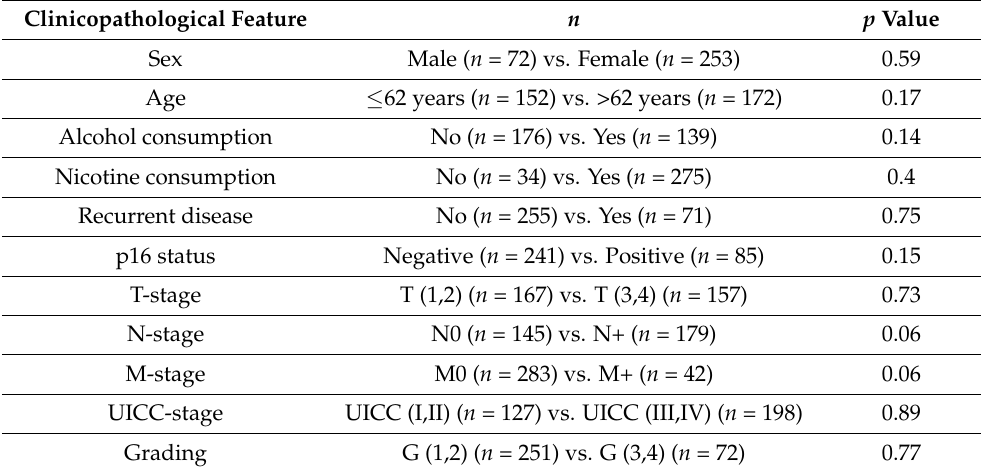
Table 3. Comparison of CDK7 expression regarding different clinicopathological